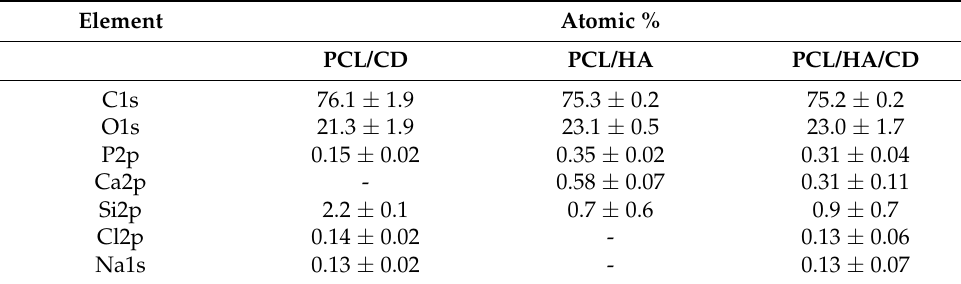
Table 6. Atomic percentages of PCL blends obtained by XPS